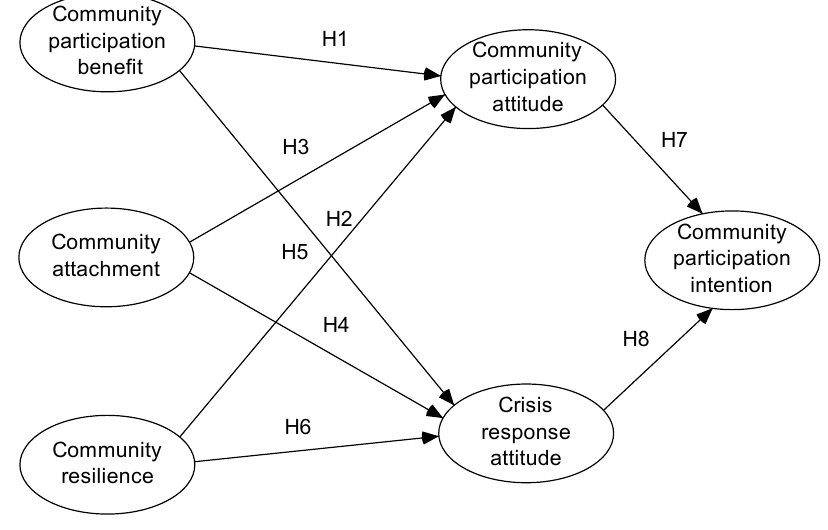
Figure 1. The theoretical model proposed by the study.